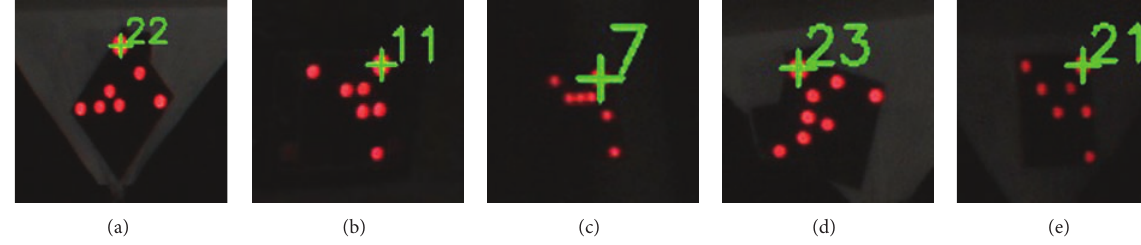
Figure 13: Detection of coded targets.